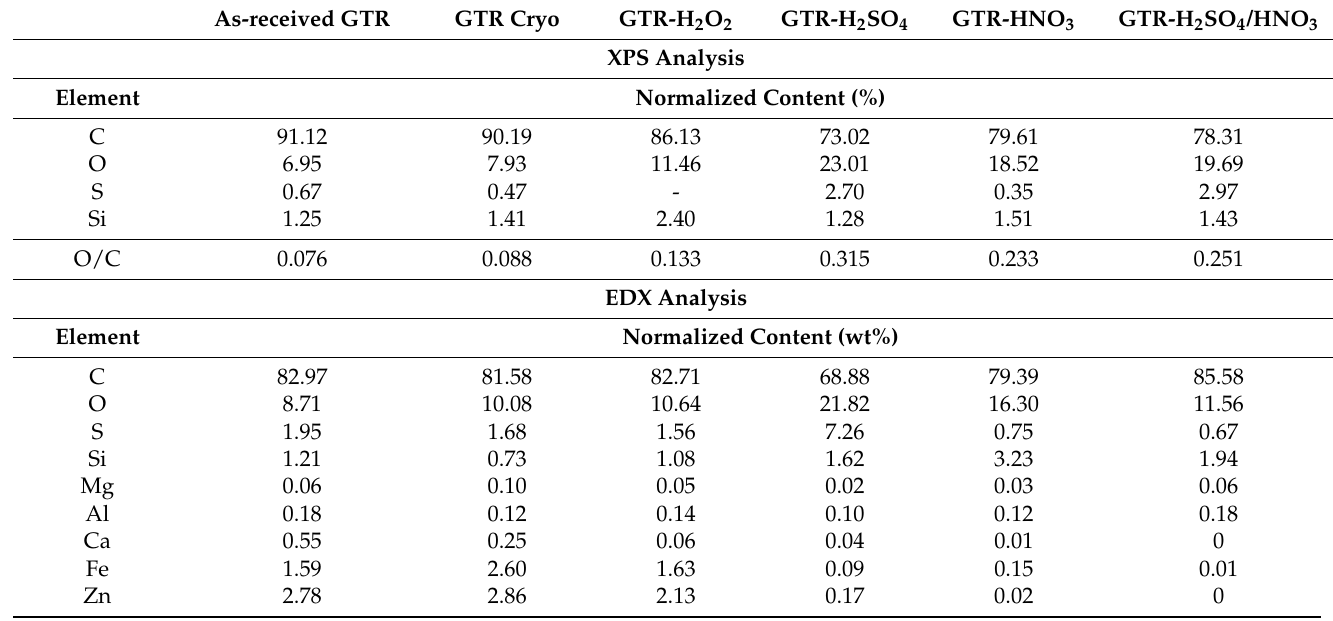
Table 4. Analysis of GTR samples by X-ray photoelectron (XPS) (surface relative element content) and EDX